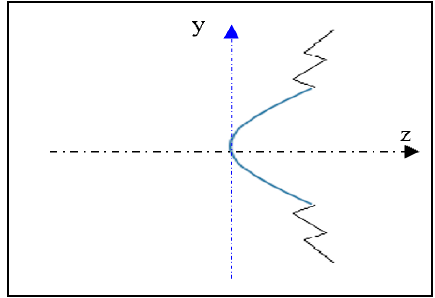
Figure 13. Segment parabolic curve antenna.